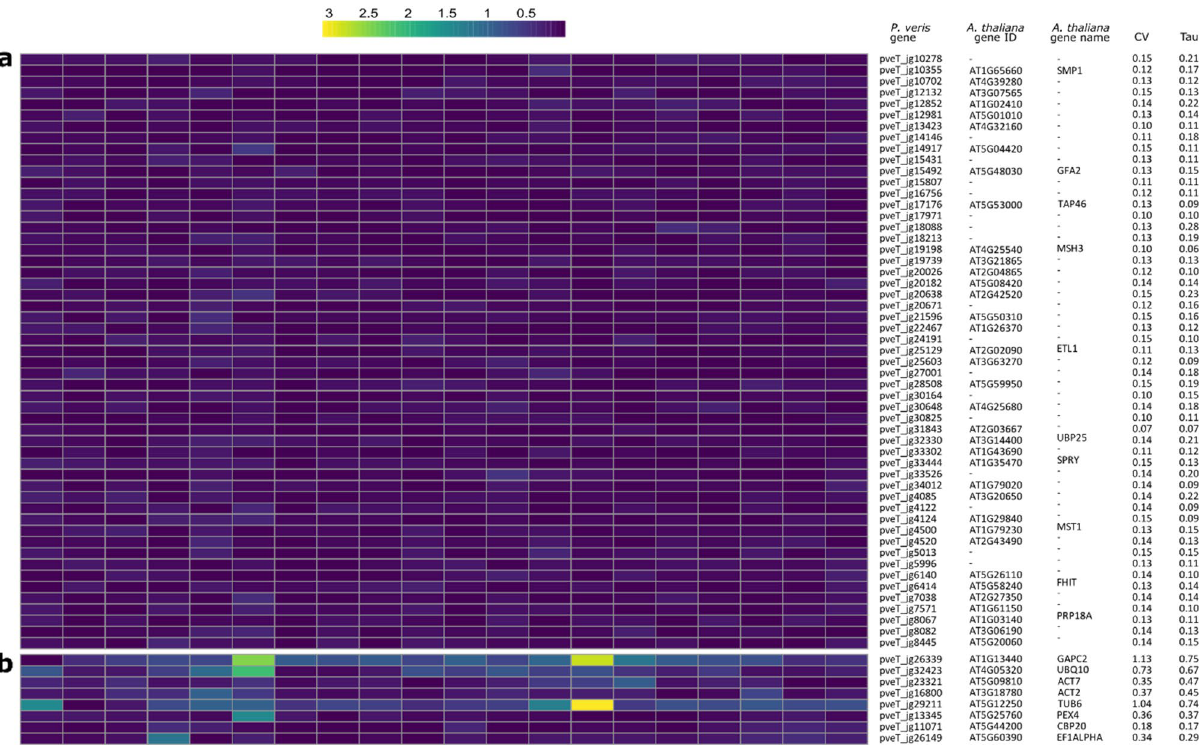
Figure 2. Constitutively expressed genes in P. veris . Heatmap showing the variability of expression for the 53 constitutively expressed genes of P. veris identified in the current study ( a ) and for eight HKGs commonly used as standards for normalizing qPCR experiments ( b ). Each cell in the heatmap represents the deviation from the mean expression (expressed in normalized read counts) for a gene (row) in a sample (column), normalized by the mean expression for that gene, calculated across all samples. The table on the right reports the P. veris gene IDs, the A. thaliana ortholog IDs and gene name (when available), the coefficient of variation (CV) and the tau tissue-specificity